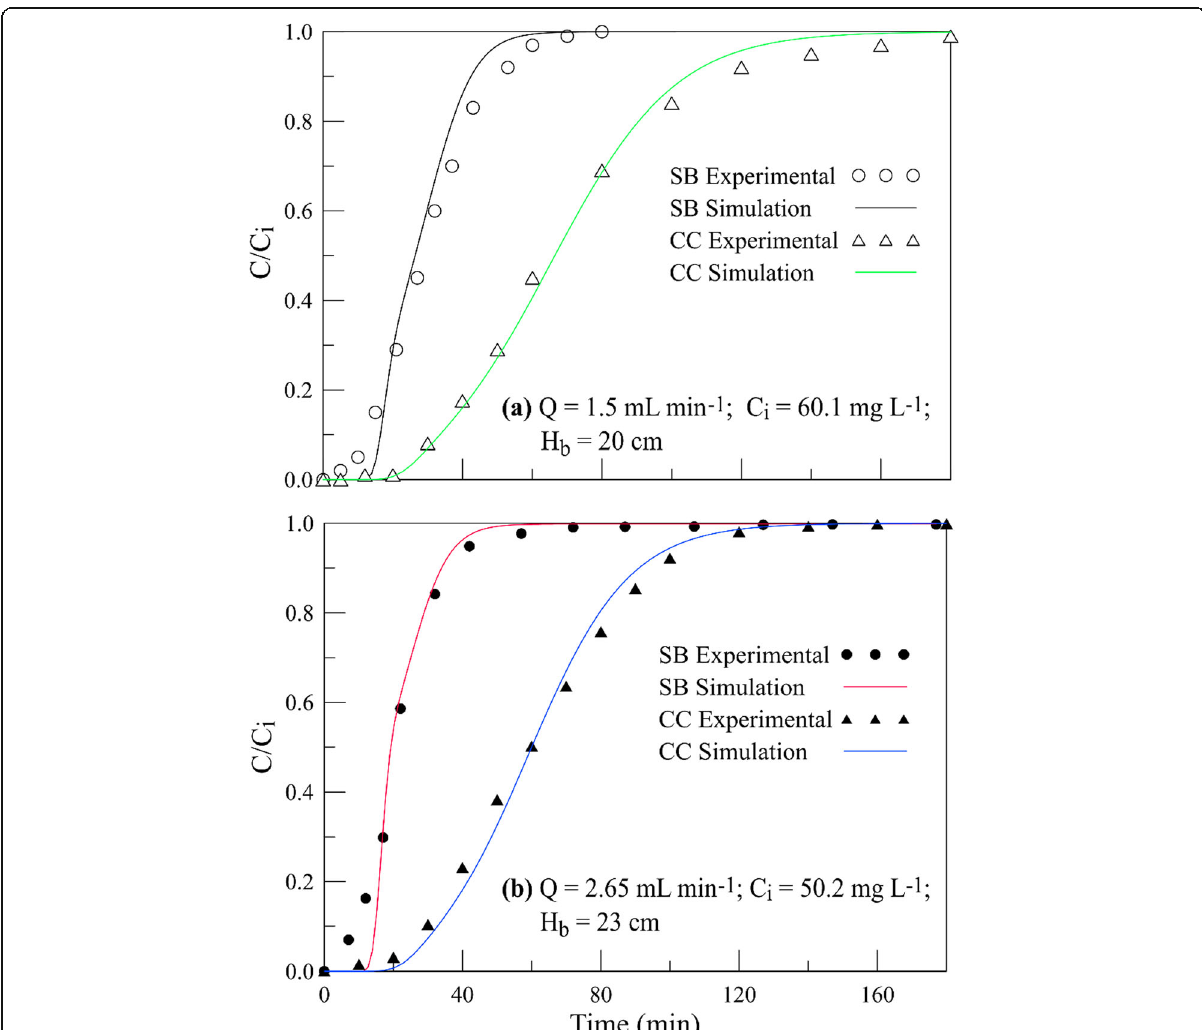
Fig. 7 Experimental and predicted breakthrough curves for ACT adsorption on SB and CC